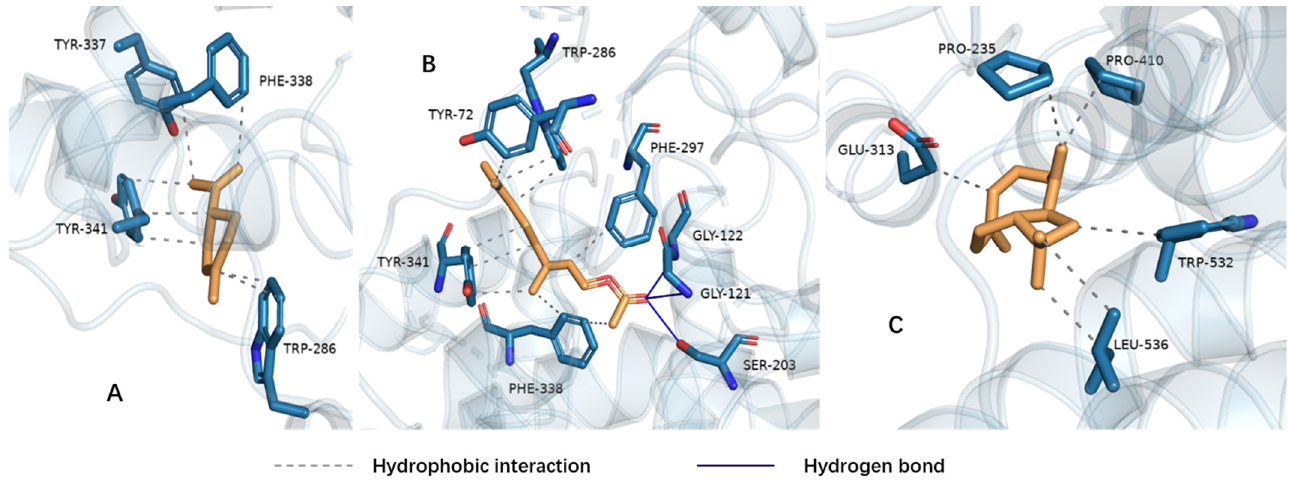
Figure 1. The interactions of acetylcholinesterase with limonene ( A ), geranyl acetate ( B ) and β-caryophyllene ( C ).